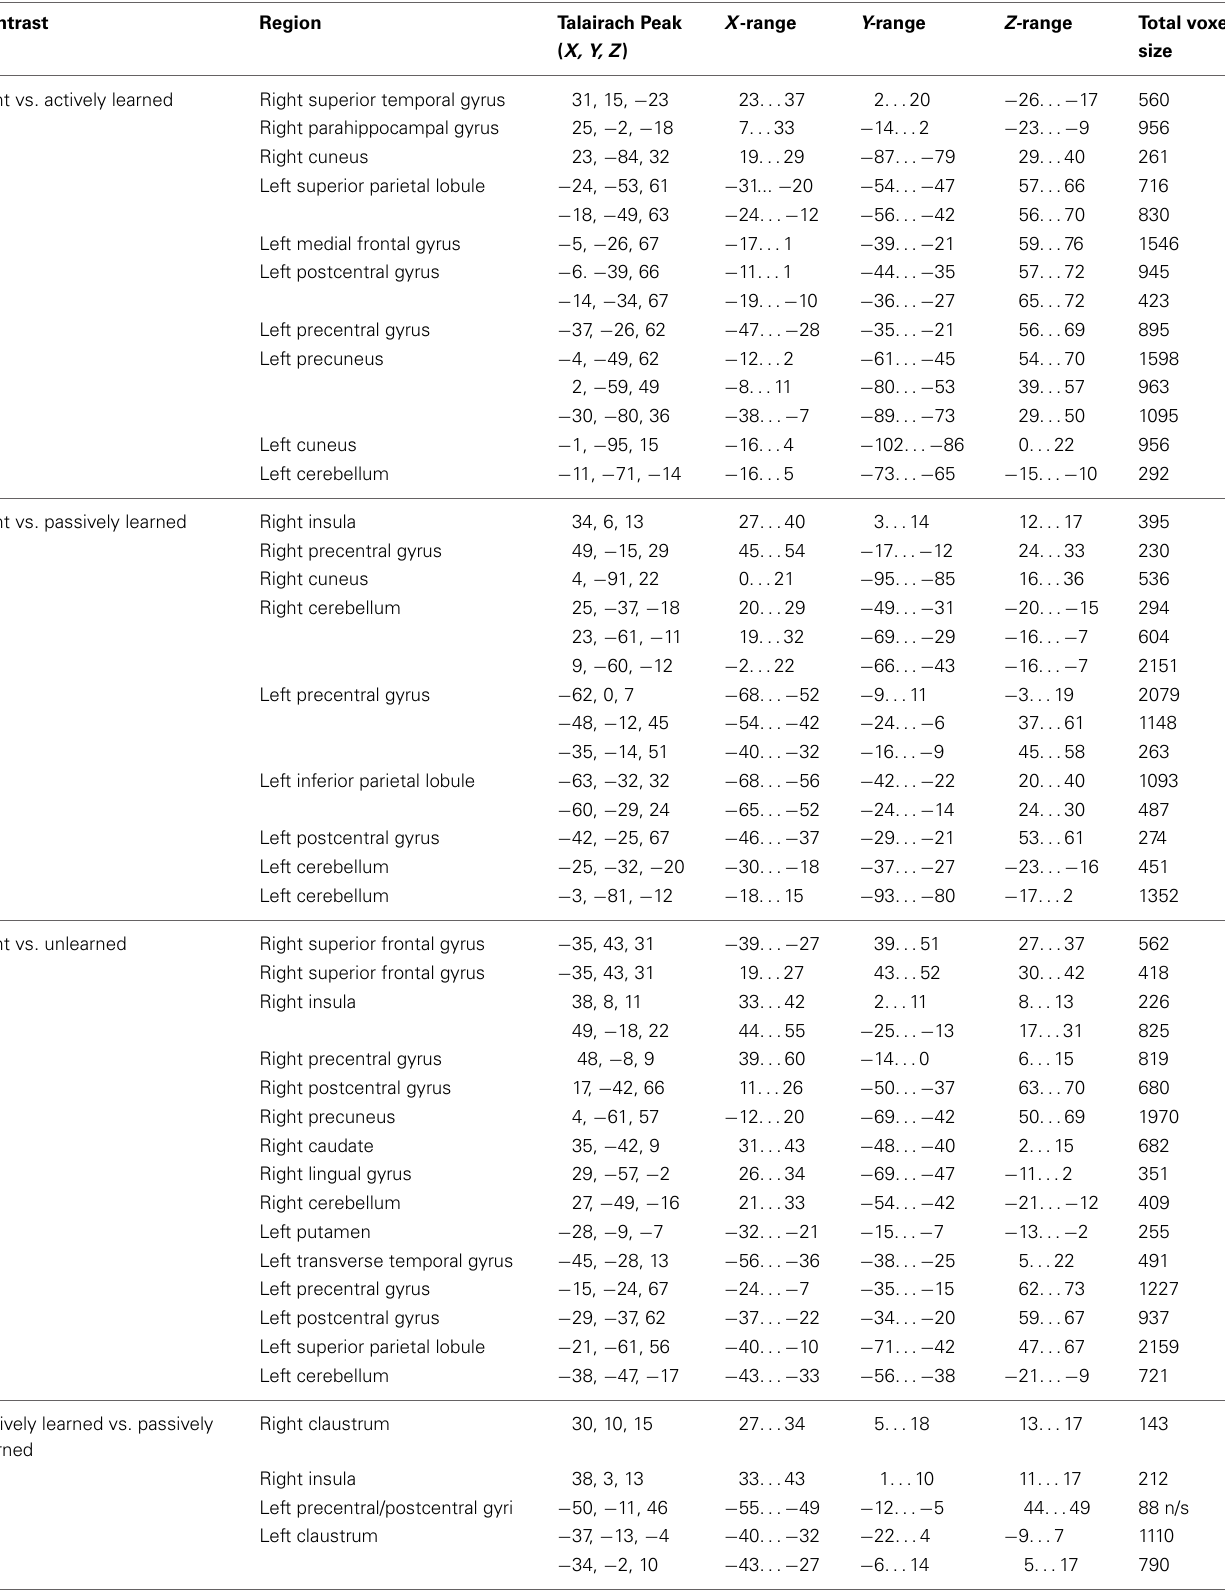
Table 1 | Peak Talairach coordinates and range of distribution for each region revealed in whole brain contrasts. Contrast